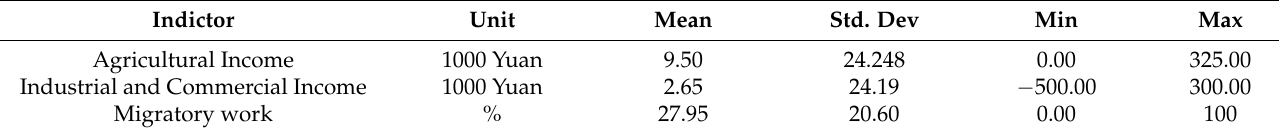
Table 3. The descriptive statistics for the mediating